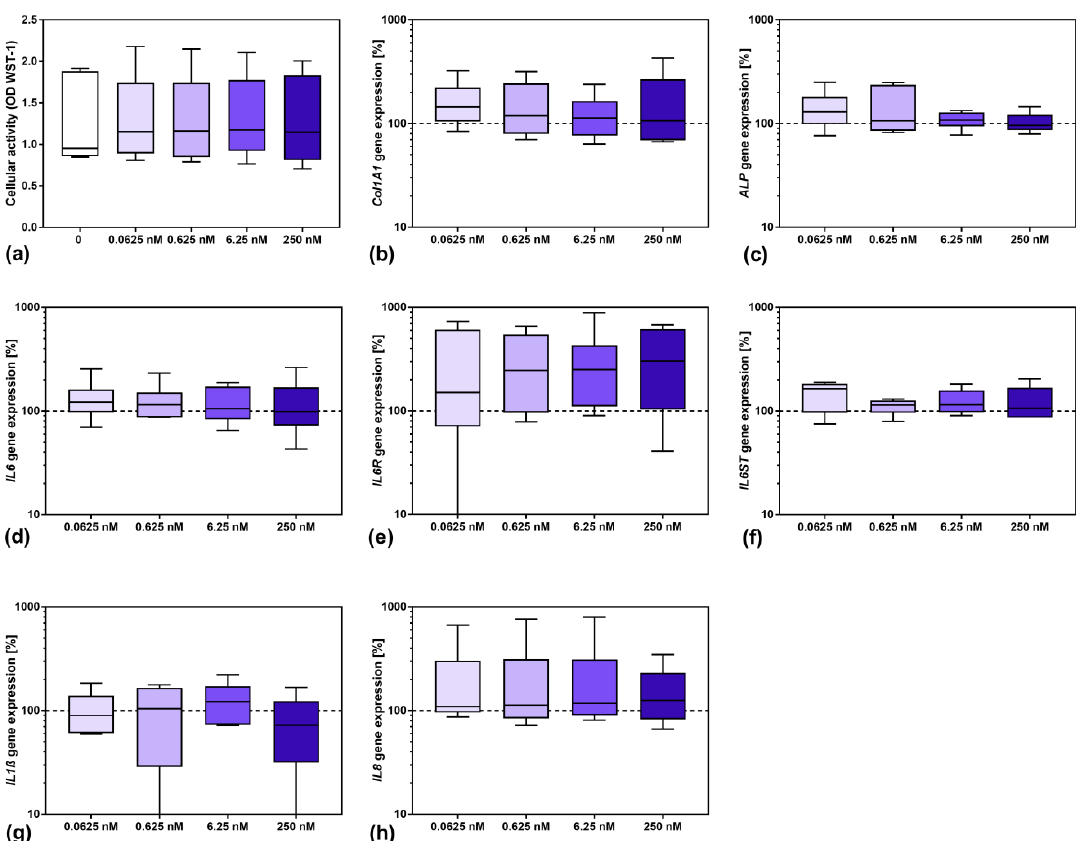
Figure 1. Influence of sarilumab on osteoblastic viability ( a ) as well as gene expression of osteogenic differentiation markers ( b , c ), and mediators involved in inflammation ( d – h ). ( a ) Cell viability was tested via water-soluble tetrazolium salt (WST-)1 assay. ( b – h ) Total RNA of human osteoblasts was isolated and gene expression patterns of the different markers were determined. Results were calculated by 2 −ΔΔCt method (% unstimulated control). All data are shown as box plots ( n = 6 independent female donors (passage 3); mean age: 77.5 ± 11.4 year; apart from gp130 with n = 5 individual female donors (passage 3); mean age: 77.8 ± 12.8 year). Statistical significance was determined via the Friedman’s test with Dunn’s multiple comparisons test as post hoc test.